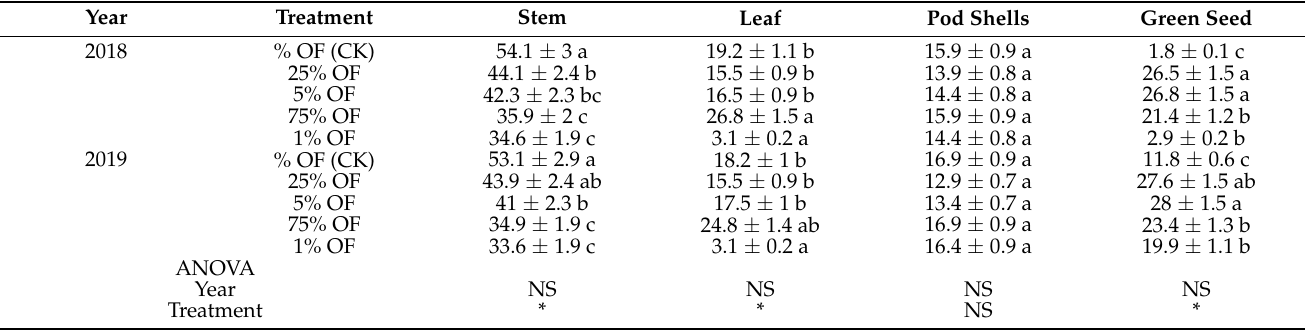
Table 4. Shoot dry matter distribution at green seed harvest for different treatments